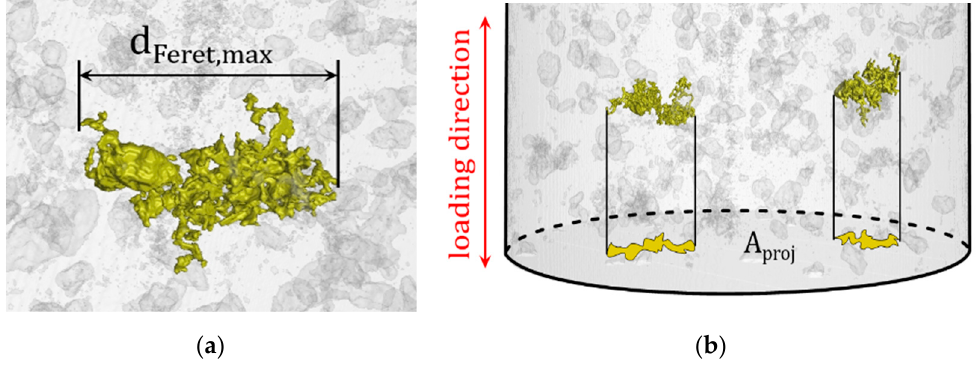
Figure 9. Characteristic parameters of single pores: ( a ) d Feret,max ; ( b ) A proj .